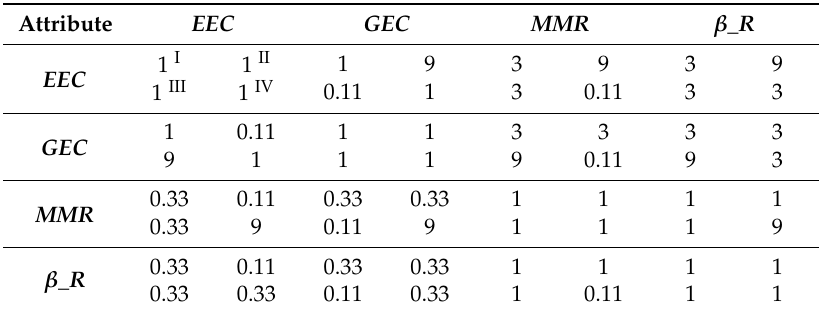
Table 5. ME opinion in different attributes.